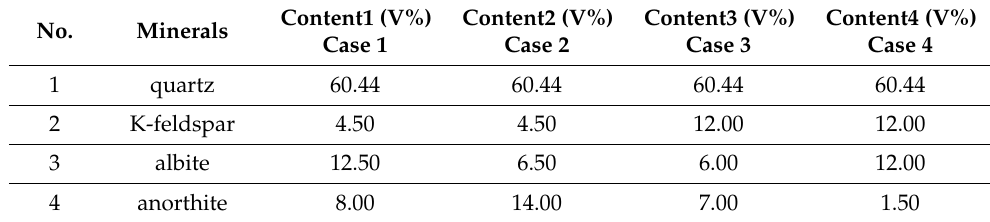
Table 2. Minerals content